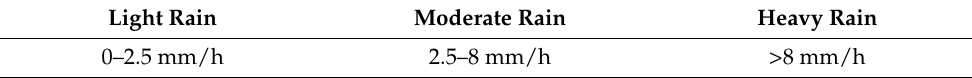
Table 2. Precipitation intensity intervals in common use.